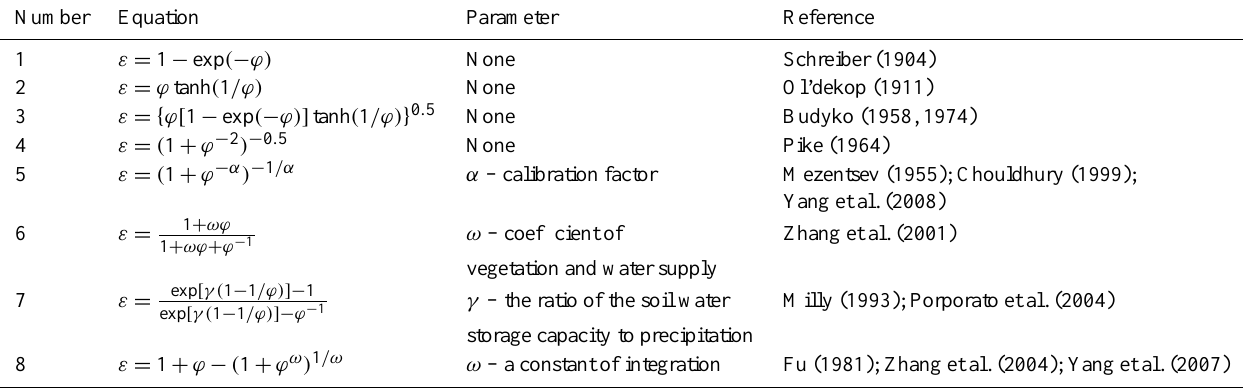
Table 1. Different Budyko equations for the mean annual water-energy